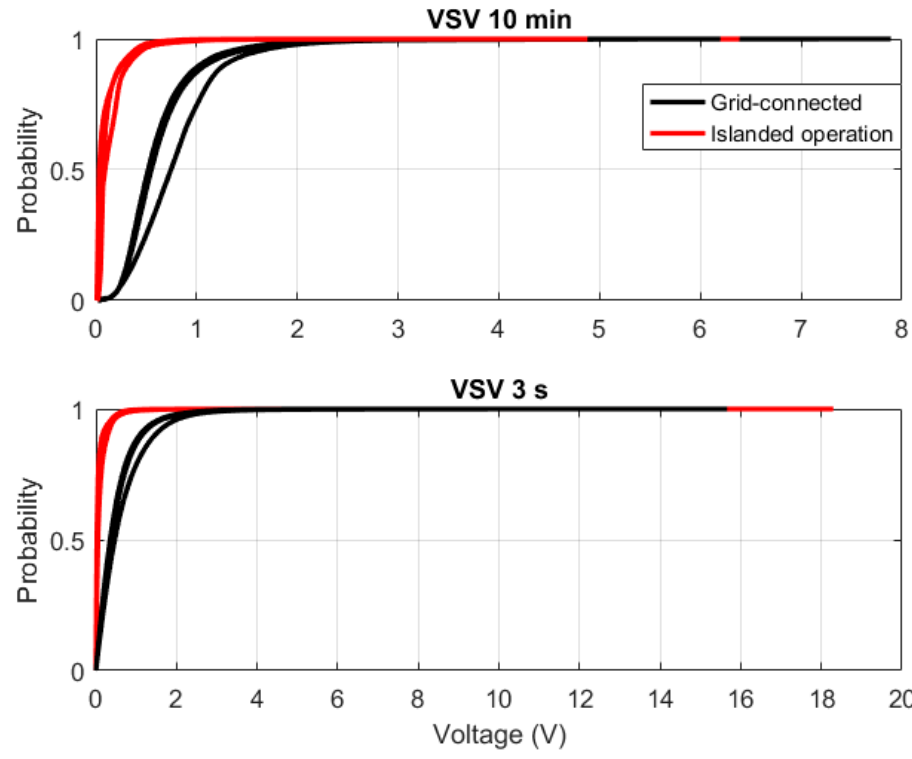
Figure 11. CDF for the 10 min very short variations (VSV) values ( top ) and the 3 s VSV values ( bottom ) for islanded and grid-connected operation. Table 7. 95% confidence interval, the maximum 3 s value and total average value for all three phases in islanded and grid-connected operation.